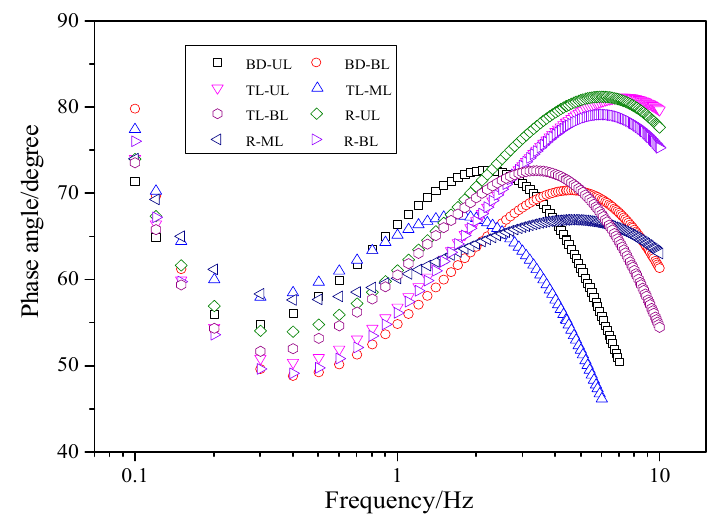
Figure 12. Phase angles of bitumen in different bituminous pavement structures.